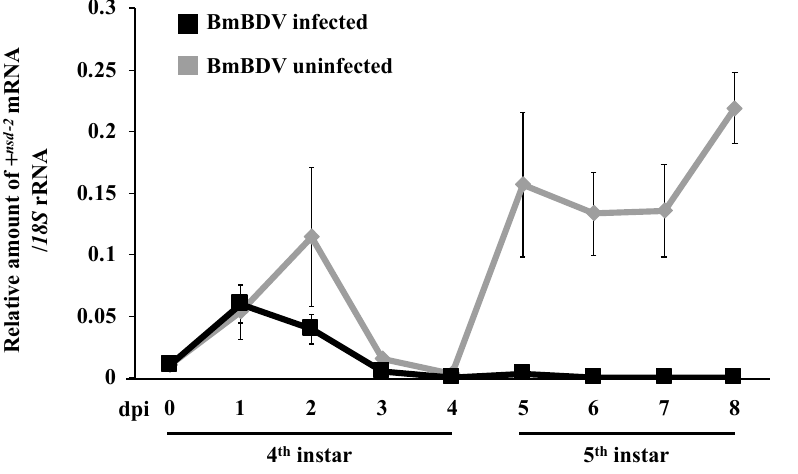
Figure 4. The time course of + nsd-2 mRNA expression in the midgut. Black and gray bars show the result of virus-infected and virus-uninfected silkworms, respectively. Four DPI indicates a molting stage. We measured these transcripts’ expression patterns using cDNA prepared from the posterior part of the midgut. We used B. mori ’s 18S rRNA as an endogenous control. Data are represented by mean ± standard error ( n = 3). This figure is a partial modification of Ito et al. [26].